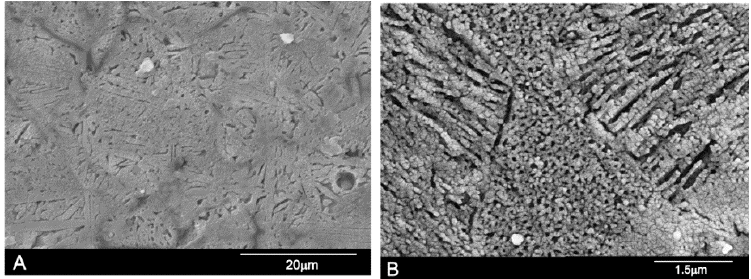
Figure 7. SEM images of sample 28.39 wt % A/71.61 wt % S. ( A ) low magnification; ( B ) high magnification.